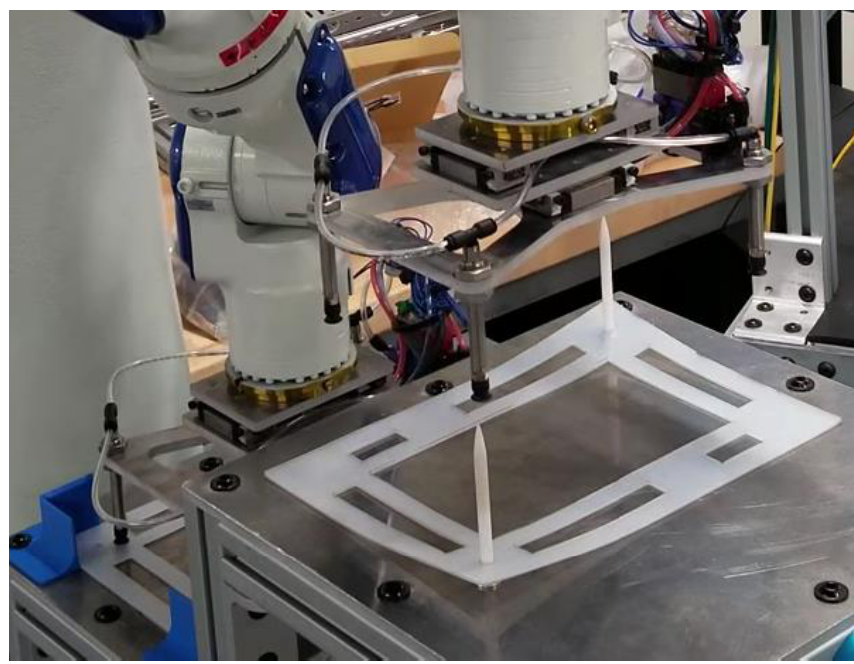
Figure 2. Fuel cell gaskets used in this research.